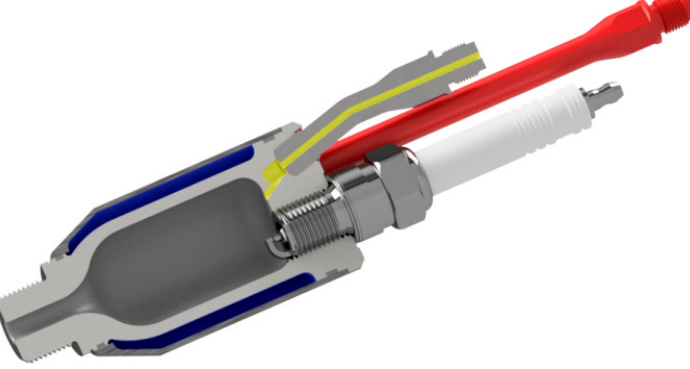
Figure 2. Cross section of ECO-JET prechamber.